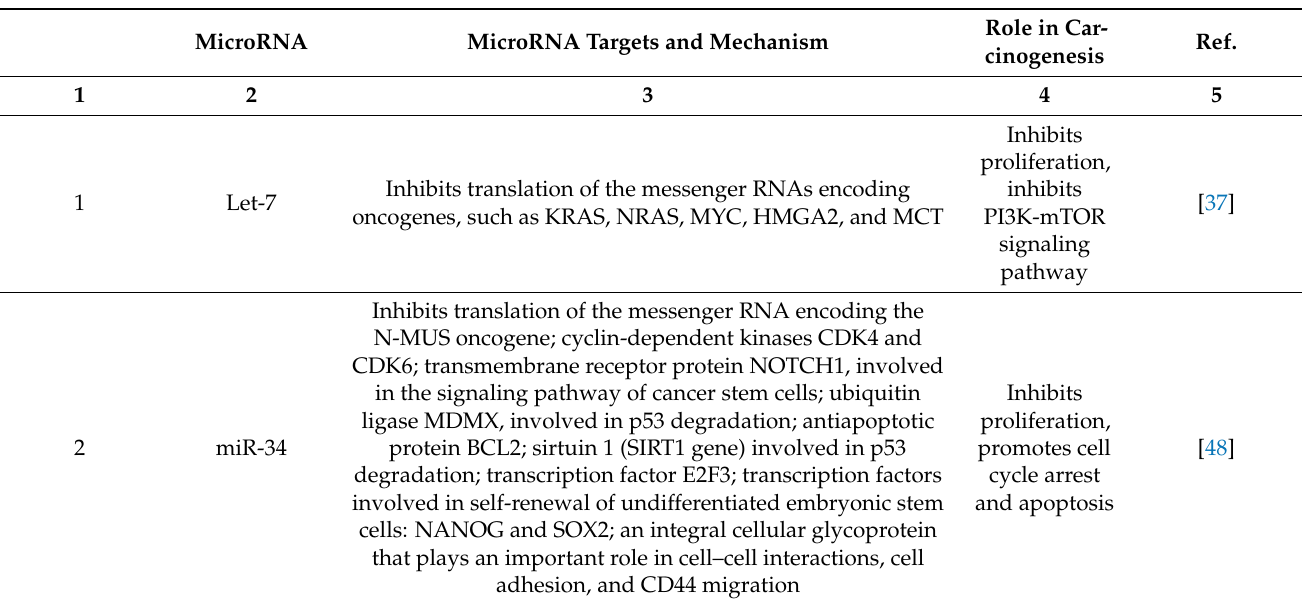
Table 2. Oncosuppressive microRNAs in lung